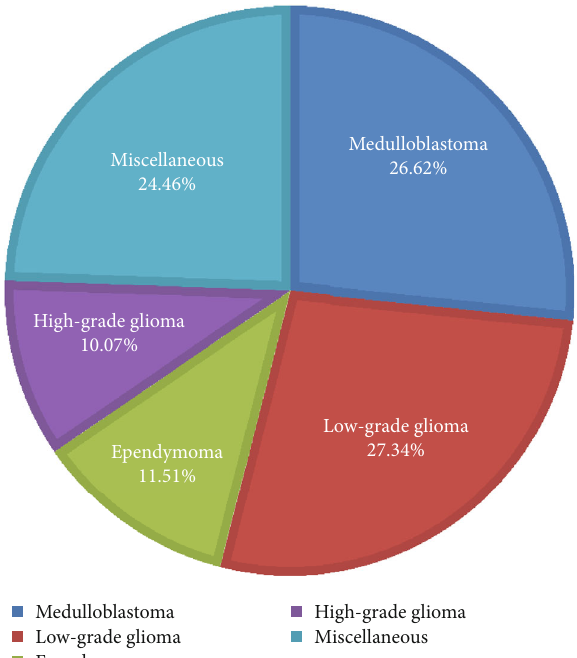
Figure 8: Distribution of all primary CNS tumors by broad histologic category for children and adolescents (0-18 years).